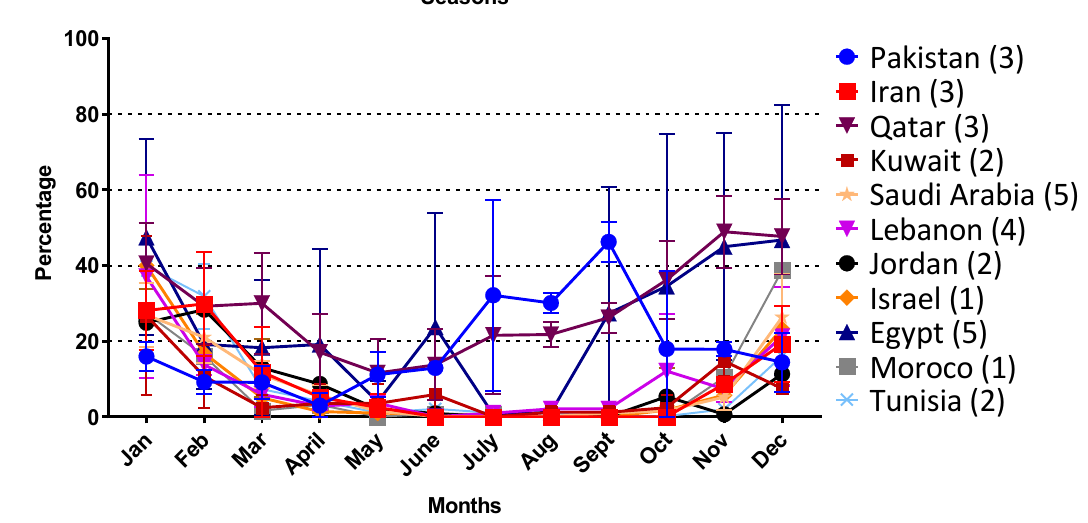
Figure 5. Seasonal distribution of Respiratory Syncytial Virus positive cases.